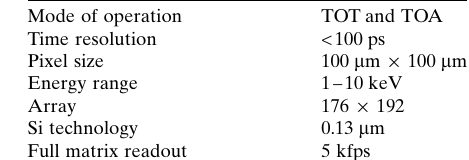
Table 1 TIXEL key performance